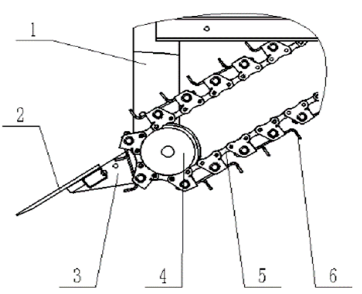
Figure 3. Schematic of the film-lifting mechanism. 1 frame; 2 shovel; 3 shovel frame; 4 driven chain roller; 5 chain bar, and 6 spring teeth.